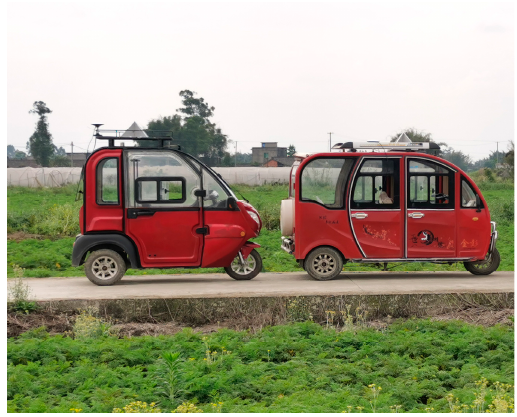
Figure 6. Two cooperative targets.